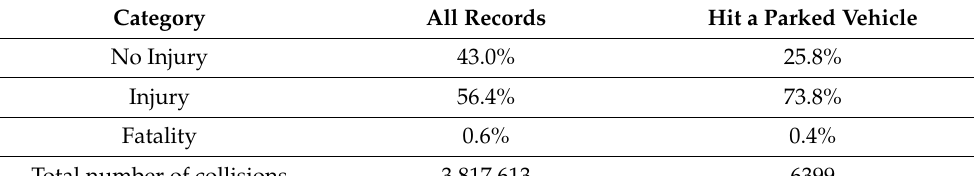
Table 4. Distribution of type of required medical treatment in collisions in NCDB [29] dataset.